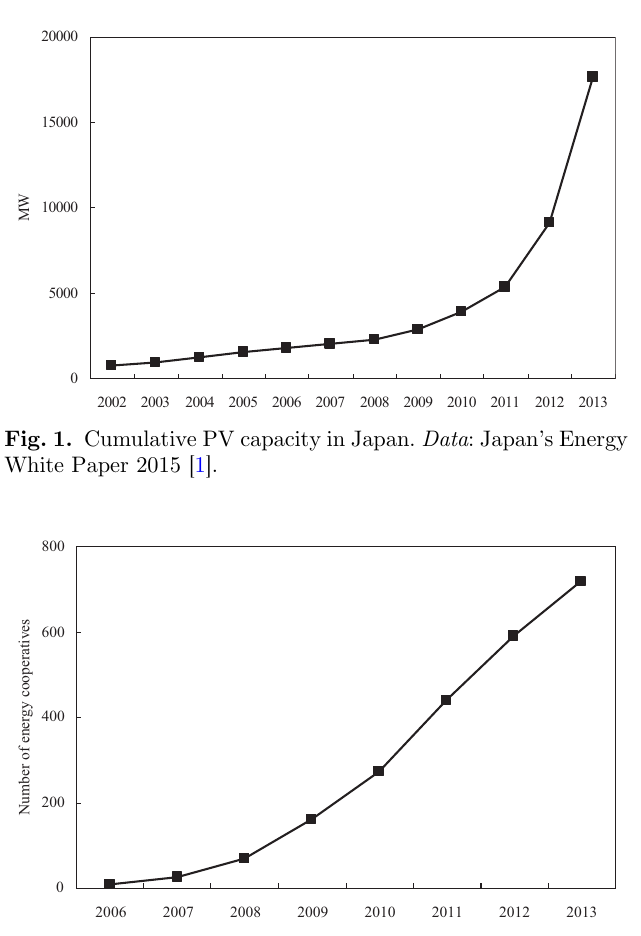
Fig. 2. Cumulative energy cooperatives in Germany. Data : DGRV Energy cooperatives survey 2014